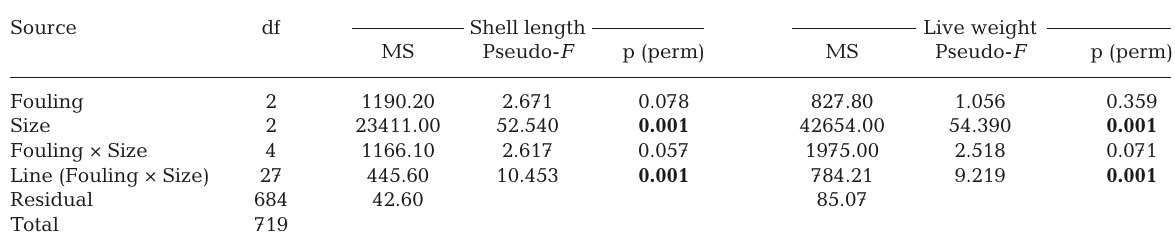
Fig. 6. Perna canaliculus . Various indices of individual mussel size: (a) shell length, (b) live weight, (c) half-shell weight, and (d) tissue dry weight for the 3 size classes (small: 20−40 mm shell length at deploy- ment, medium: 40−60 mm, and large: 60−70 mm) and fouling treat- ments (controls, ambient fouling, and enhanced Didemnum vexillum fouling). Crossbar inside each box indicates median; lower and upper box limits represent the 25th and 75th percentiles, respectively; bot- tom and top whiskers represent 10th and 90th percentiles, respec- tively; while lower and upper circles represent 5th and 95th percentiles, respectively